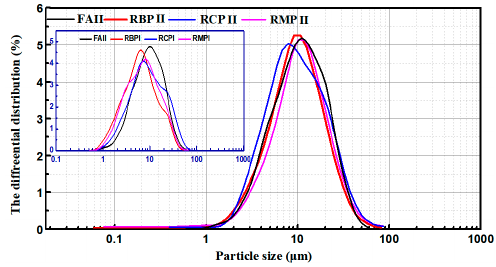
Figure 5. Particle size distribution of RP.